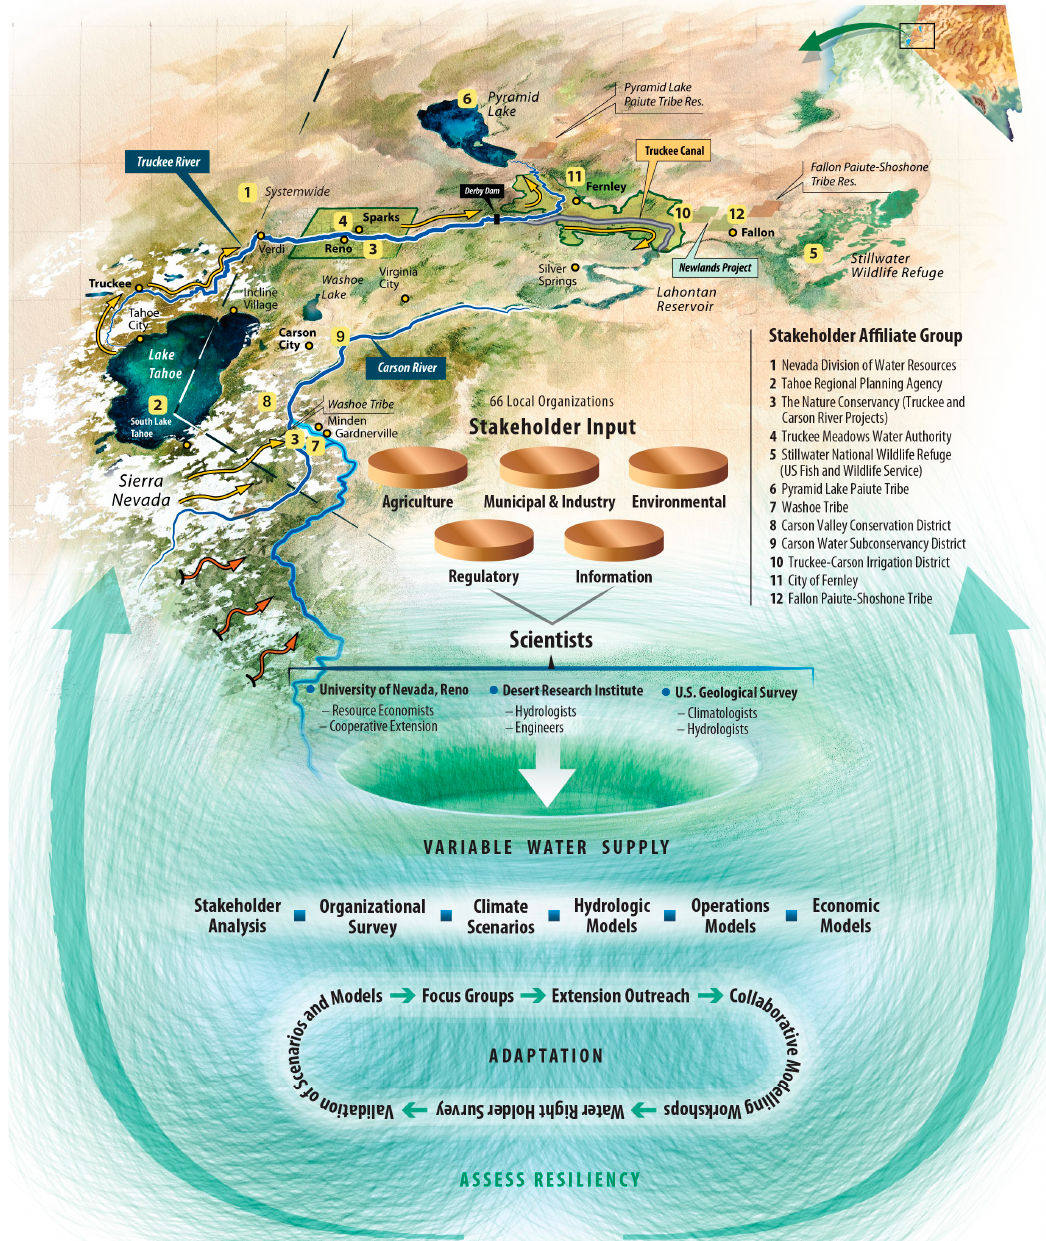
Figure 2. Case study collaborative modeling research design.